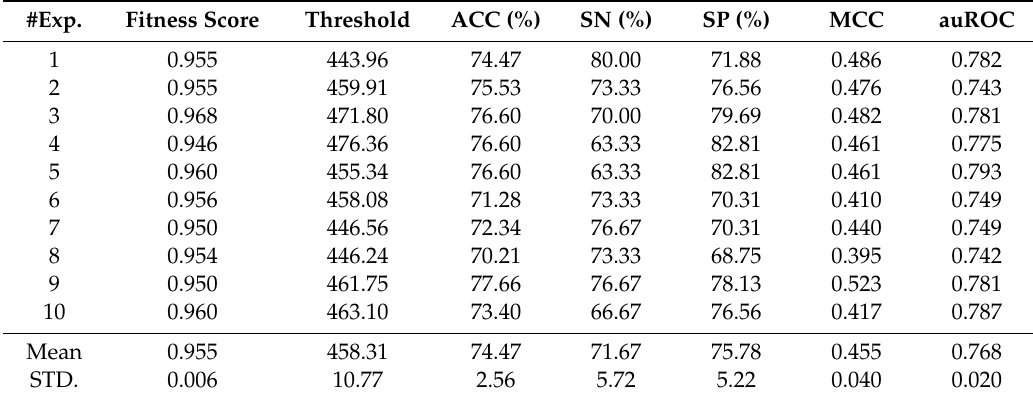
Table 3. Comparison of ten SCM models with ten di ff erent optimized dipeptide propensity scores (opti-DPS) over independent validation